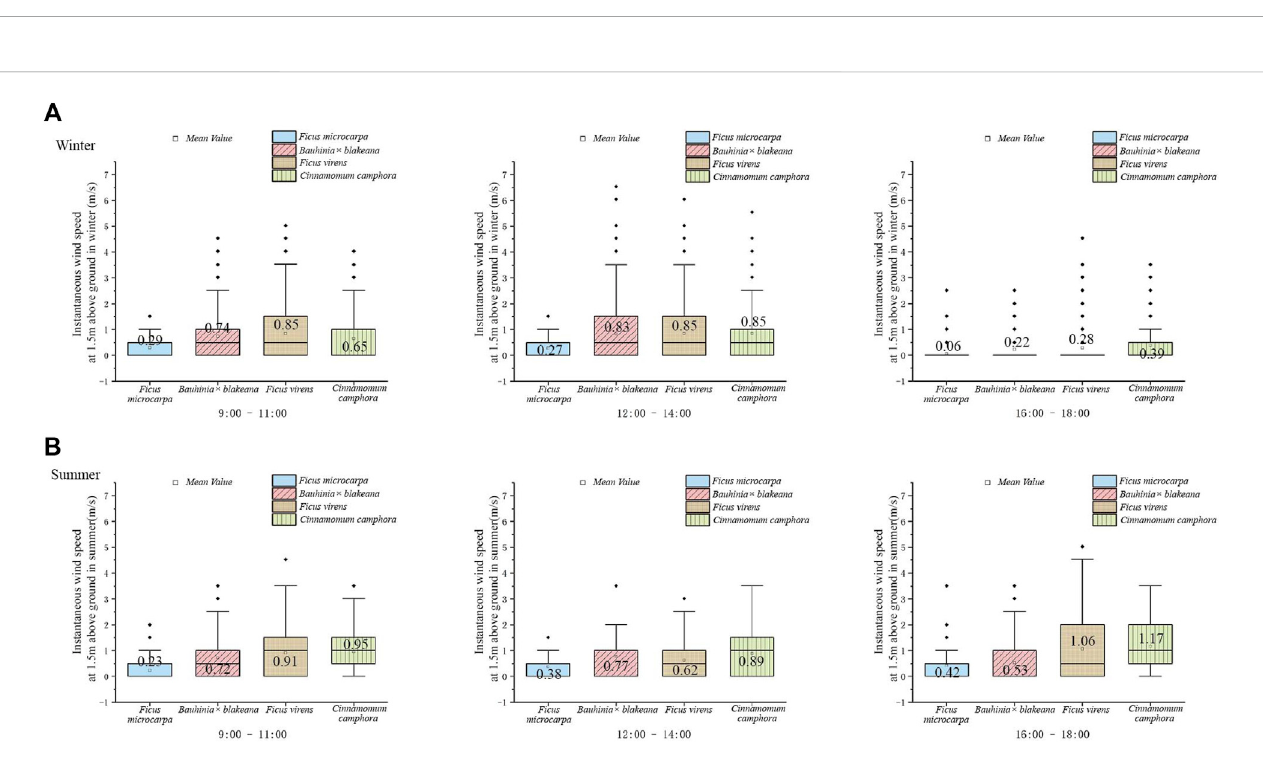
Instantaneous wind speed underneath the canopy of the four tree species in winter (A) and summer (B)